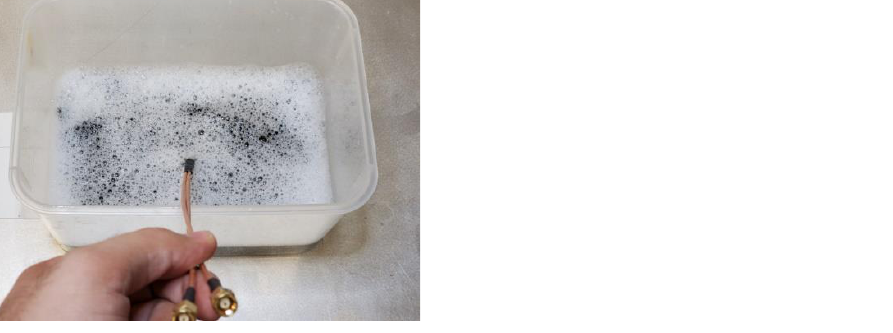
Figure 11. The fabric is completely submerged in water and detergent. The SMA connectors are held outside.